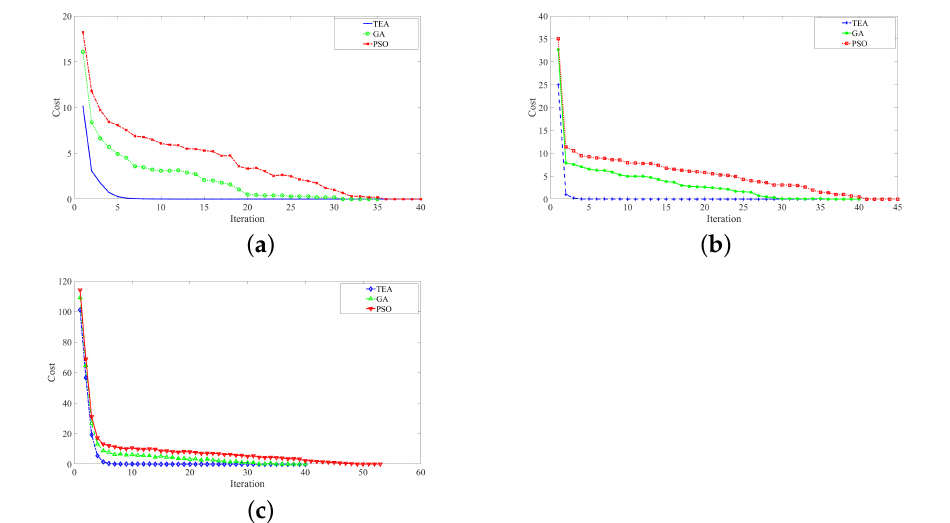
Figure 9. Minimum costs of TEA, GA, and PSO versus iteration are compared: ( a ) f 1 , ( b ) f 2 , and ( c ) f 3 (convergence speed).